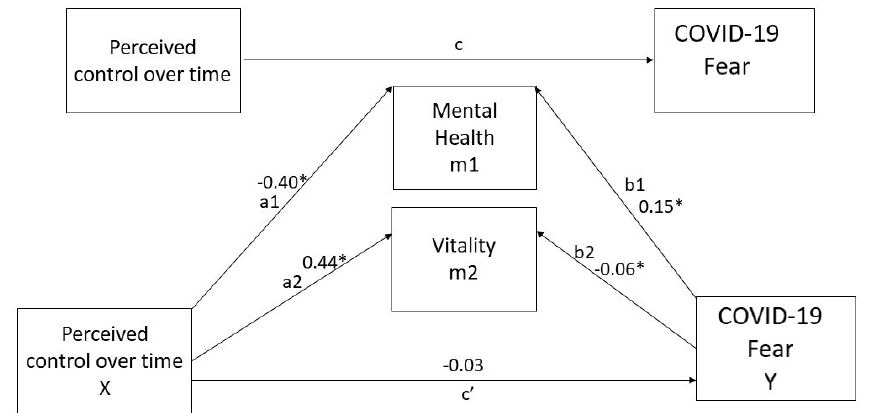
Figure 2. The mediating effect of mental health dimensions in the relationship between perceived control over time and fear of COVID-19. Note: * p < 0.001. All the presented effects are unstandardized. Similarly, in the model, fear of COVID-19 was regressed on mental health (path b1).